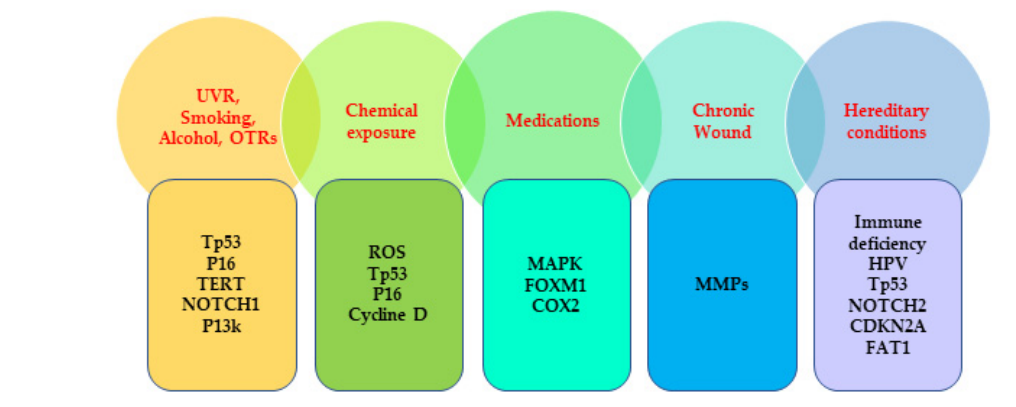
cyclin-dependent kinase inhibitor 2A; FAT1, FAT atypical cadherin